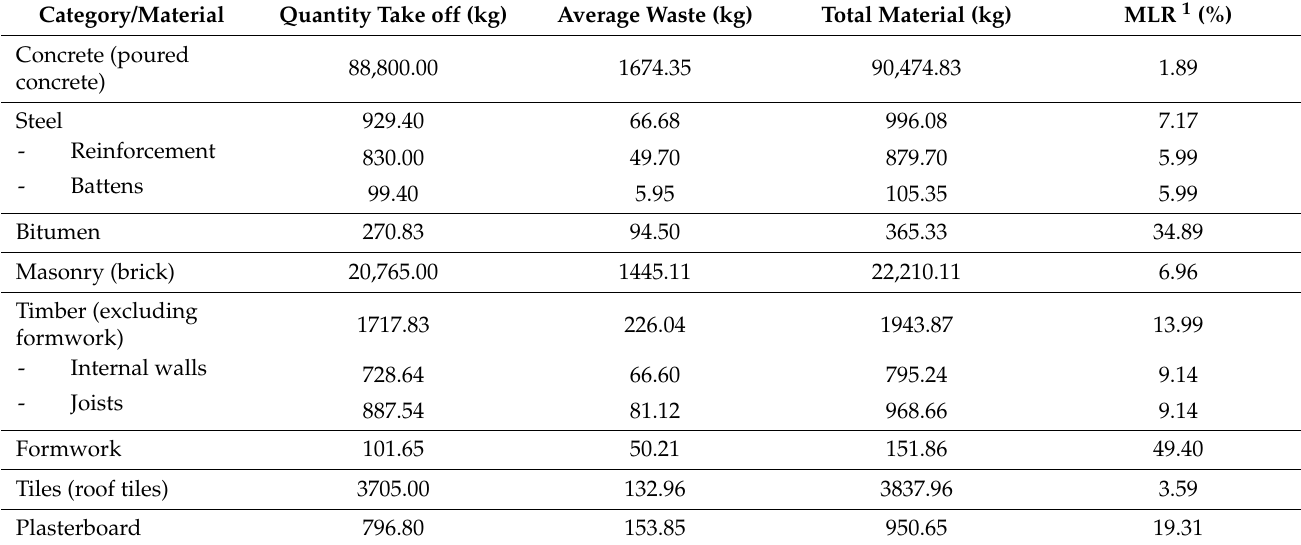
Table 5. Average waste generation for Case A conventional